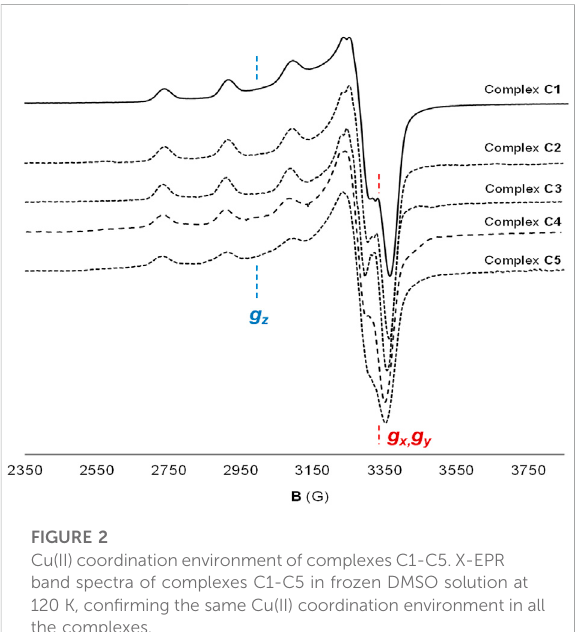
FIGURE 2 Cu(II) coordination environment of complexes C1-C5. X-EPR band spectra of complexes C1-C5 in frozen DMSO solution at 120 K, con fi rming the same Cu(II) coordination environment in all the complexes.